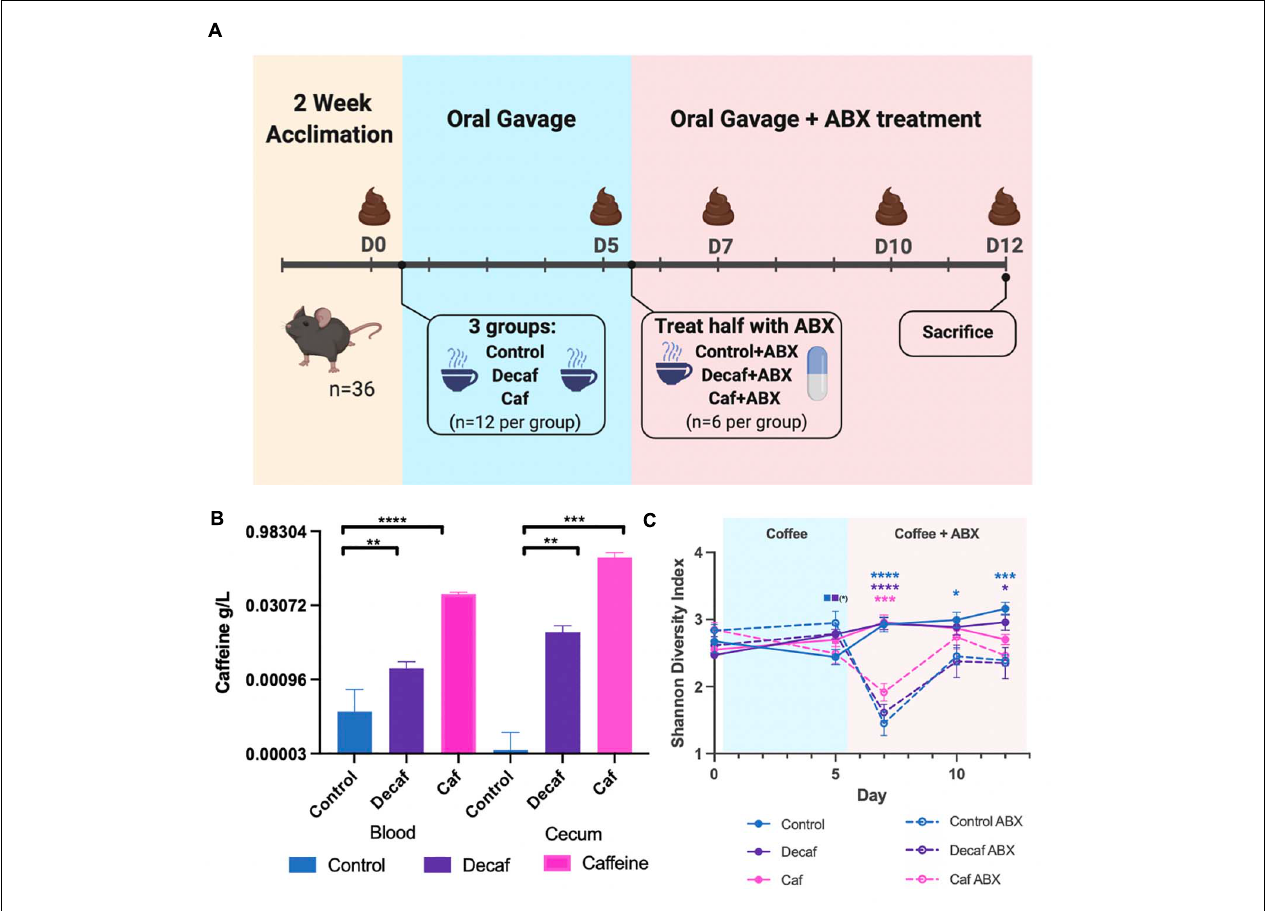
FIGURE 1 | (A) Mouse experimental design and timeline. Figure was created with biorender.com. (B) Quantification of caffeine content in blood and cecum 1-h post-oral gavage ( n = 6). (C) Alpha diversity of experimental groups as measured by the Shannon Diversity Index. Data are represented as mean ± standard deviation (SD). Significance between each group and its antibiotic counterpart is denoted by stars (*) with the color coordinating to control (ctrl, blue), decaffeinated coffee (decaf, purple), or caffeinated coffee (caf, pink). Significance between different experimental groups is denoted by squares color-coded according to the experimental groups being compared. Significance was determined by the Benjamini, Krieger and Yekutieli test to correct for False discoveries with adjusted p -value < 0.05. (*, 0.01 < P < 0.05; **, 0.001 < P < 0.01; ***, 0.0001 < P < 0.001; ****, P < 0.0001). Solid squares represent groups without antibiotics, open squares represent groups given antibiotics. Each comparison of two experimental groups has its corresponding significance denoted in stars (*) next to it. n = 6. For example, on Day 5, the solid blue square next to the solid purple square represents a significant difference between the control non-antibiotic group and the decaf non-antibiotic group, at a significance level of 1 star (shown in parentheses). On Day 12, the 3 blue stars represent a significant difference between the control non-antibiotic group and the control antibiotic group, at a significance level of 3 stars. The 1 purple star represents a significant difference between the decaf non-antibiotic group and the decaf antibiotic group at a significance level of 1